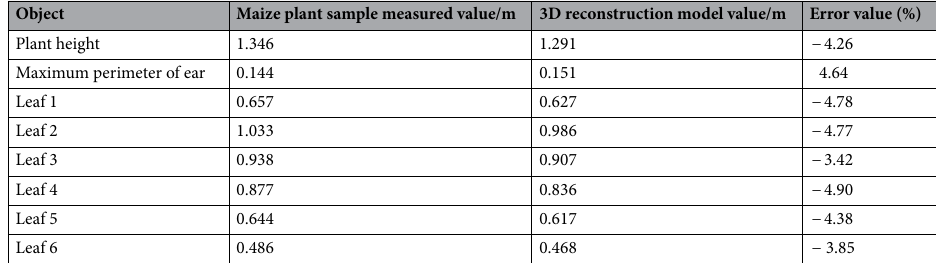
Table 7. Comparison of the measured values of key parts between sample and3D reconstruction